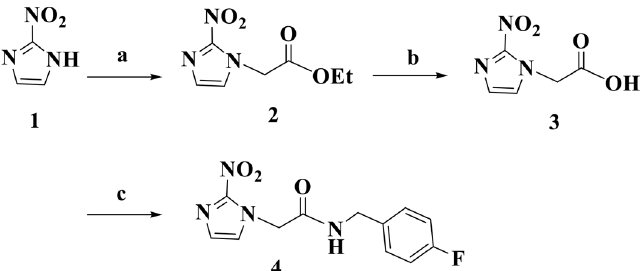
Scheme 1 Synthesis of the labeling precursor 3 and reference compound 4 . Reagents and conditions: (a)